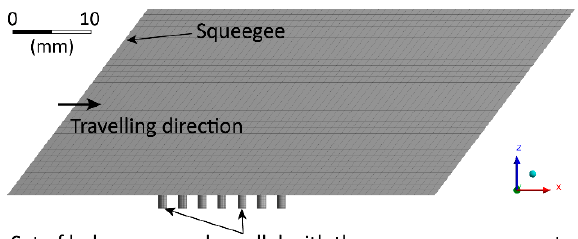
Figure 7. Numerical model, where the through-holes are arranged in parallel with the travelling direction of the squeegee. The seven consecutive through-holes are distributed evenly at distances of 2.54 mm